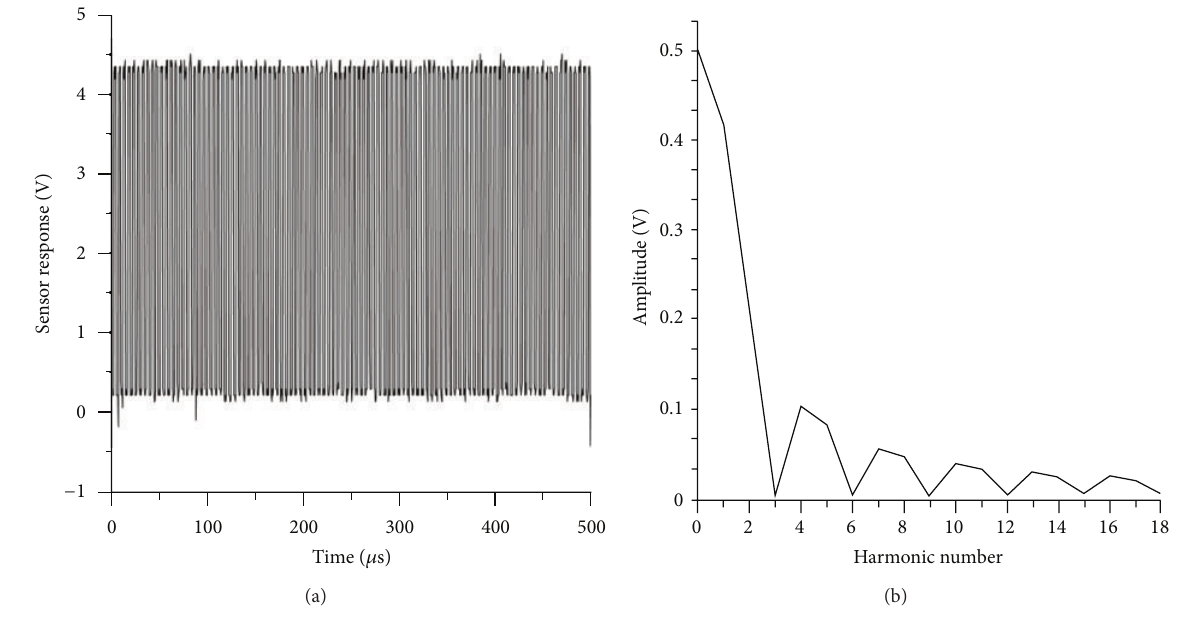
Figure 6: Response concrete tile. (a) Response of the oscillator. (b) Analysis gives harmonics of the sensor response.